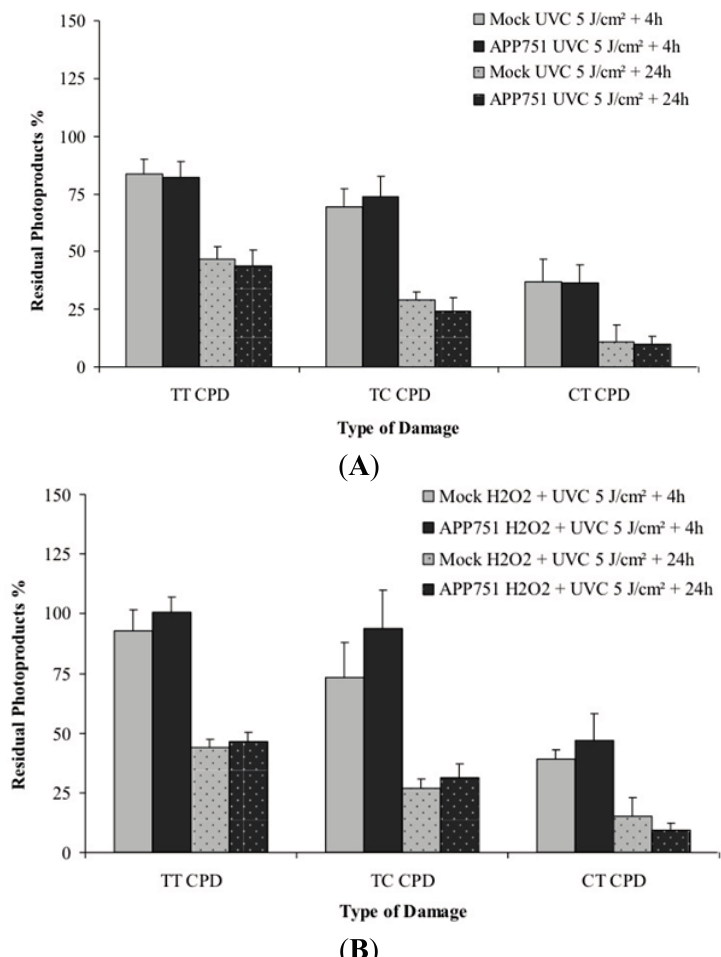
Figure 5. Assessments of the photoproducts repair kinetics in the mock and APP751-expressing cells. Persistence of cyclobutane dimers within Mock and APP751-expressing cells exposed to UVC (5 J/m 2 ) radiation without ( A ) or with H 2 O 2 pre-treatment ( B ). Repair of TT CPD, TC CPD and CT CPD are shown. The results are expressed in percentage of residual lesions and are the average ± SD of data